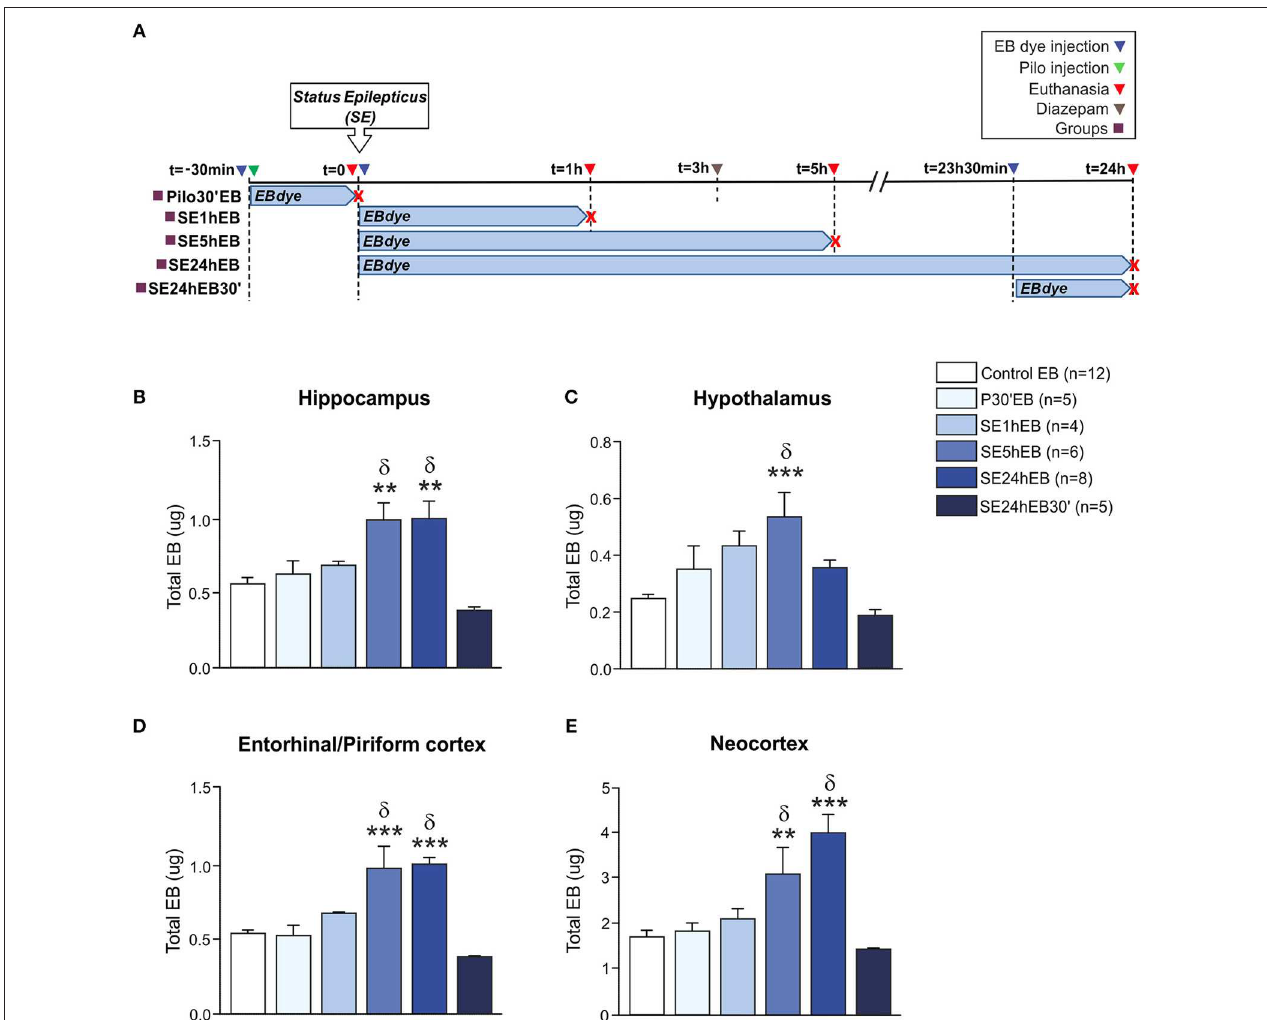
FIGURE 2 | BBB breakdown to the EB dye during the acute phase of the pilocarpine model of epilepsy. In (A) , a schematic representation of the experimental design for evaluation of the BBB permeability to macromolecules: in the Pilo30’EB group, Evans blue (EB) dye was intravenously injected immediately before pilocarpine (i.p.), and the animals were euthanized 30min after PILO injection. In the SE1hEB group, the EB dye was injected at the beginning of the status epilepticus (SE), and animals were euthanized 1h after SE onset. In the SE5hEB group, EB dye was injected at the beginning of the SE, and animals euthanized 5h after SE onset. In the SE24hEB group, EB dye was injected at the beginning of the SE, and animals were euthanized 24h after SE onset. In the SE24hEB30’ group, EB dye was injected 23h 30min after the beginning of the SE, and the animals were euthanized 24h after SE onset (i.e., EB dye remained in the bloodstream for 30min). Note that rats from groups SE5hEB, SE24hEB, and SE24hEB30’ had seizures blocked with diazepam 3h after SE initiation. In (B–E) , quantitative analysis shows that BBB tracer EB can be detected only between 5 and 24h after SE beginning in the hippocampus (B) , hypothalamus (C) , entorhinal/piriform cortex (D) , and neocortex (E) . Data expressed as mean ± SEM. ** p < 0.01, *** p < 0.001 in comparison with control groups and δ p < 0.001 in comparison with SE24hEB30min by one-way ANCOVA (mass of the region as covariate) and Sidak post-hoc .